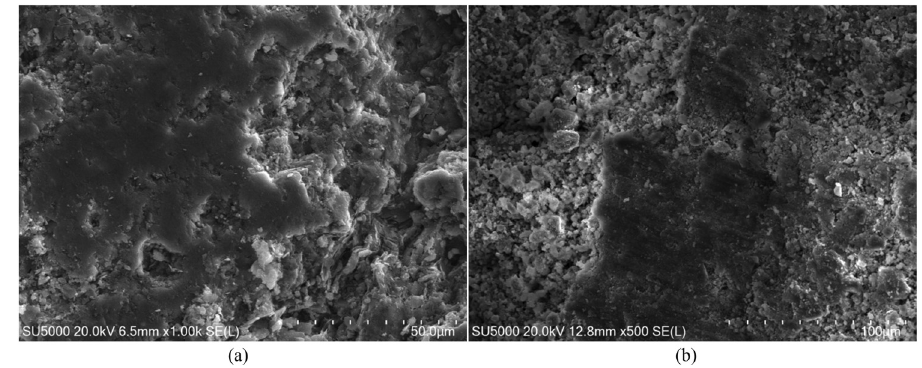
Figure 22: Micro - structure of the ITZ between RA and cement mortar before and after NS modi fi cation. ( a ) NS - 0. ( b ) NS - 2%.